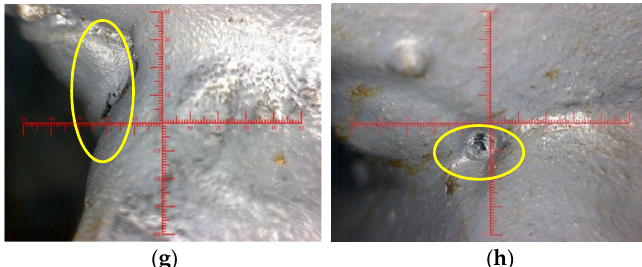
Figure 7. Partial enlargement photos of typical weld defect before the fatigue test. ( a ) South side of the CB/SB1 joint. ( b ) North side of the CB/SB1 joint. ( c ) South side of the CB/SB2 joint. ( d ) North side of the CB/SB2 joint. ( e ) South side of the CB/SB3 joint. ( f ) North side of the CB/SB3 joint. ( g ) South side of the CB/SB4 joint. ( h ) North side of the CB/SB4 joint.